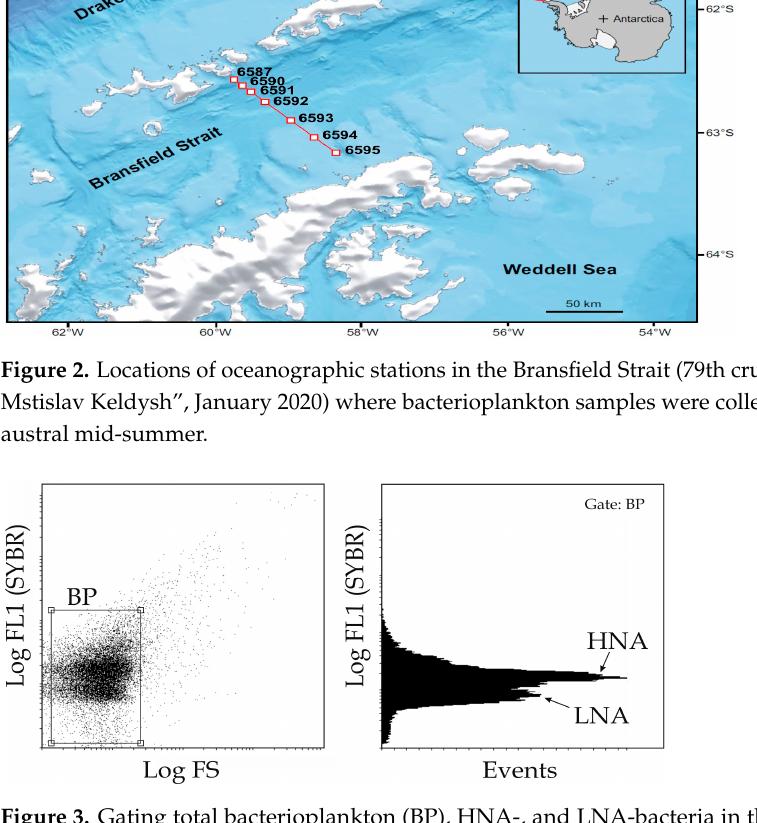
Figure 2. Locations of oceanographic stations in the Bransfield Strait (79th cruise of R/V “Akademik Mstislav Keldysh”, January 2020) where bacterioplankton samples were collected at 5 to 7 depths in austral mid-summer.